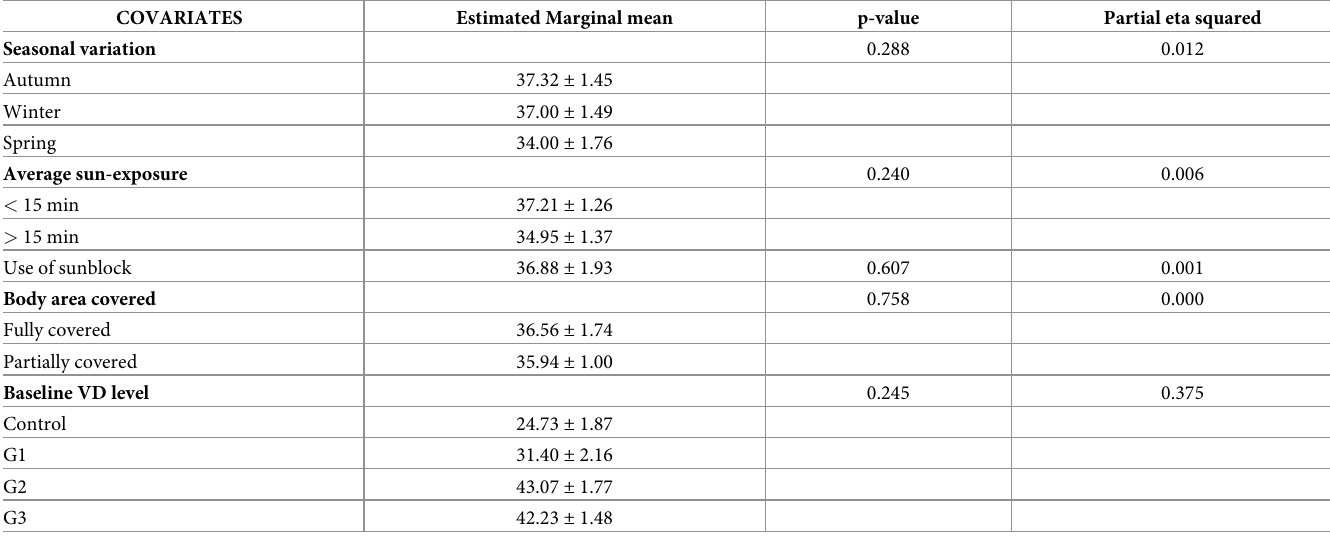
Table 3. Relationship of confounding factors with respect to treatment groups.